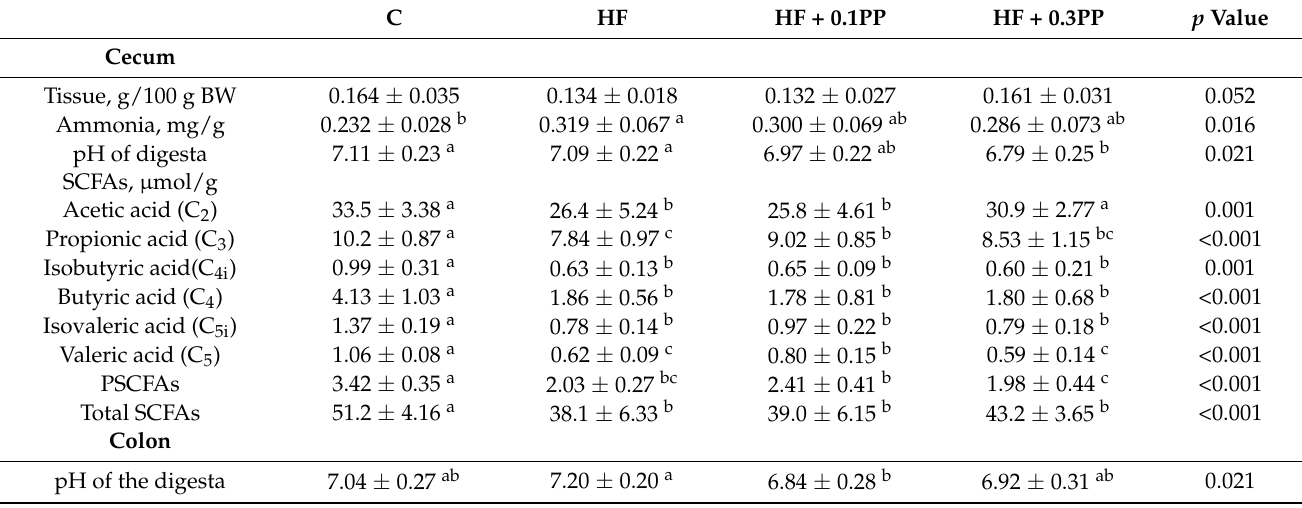
Table 4. Large bowel parameters of and microbial SCFA production in rats fed experimental